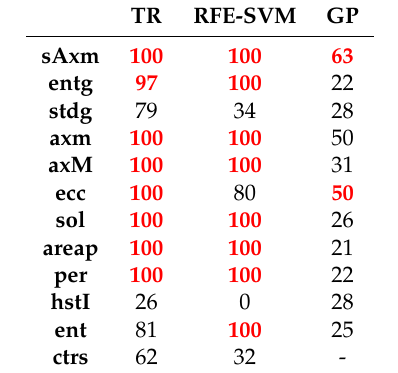
Table 6. Occurrence percentage of the features selected by the three methods. Values highlighted in red are the image-features used by the processing component of the GUARD1 imaging system.